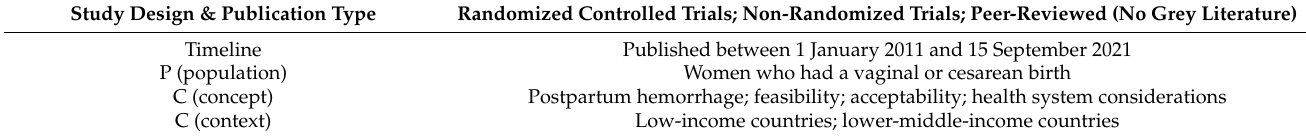
Table 1. Eligibility